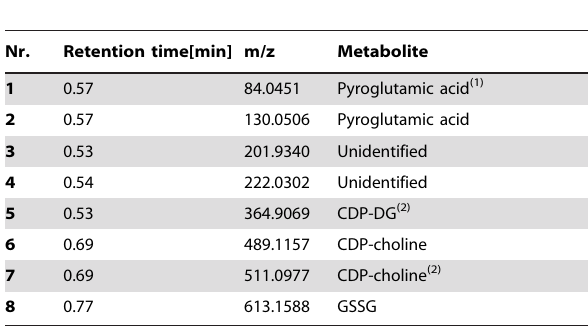
Table 3. List of selected differentiating metabolites from the retina data